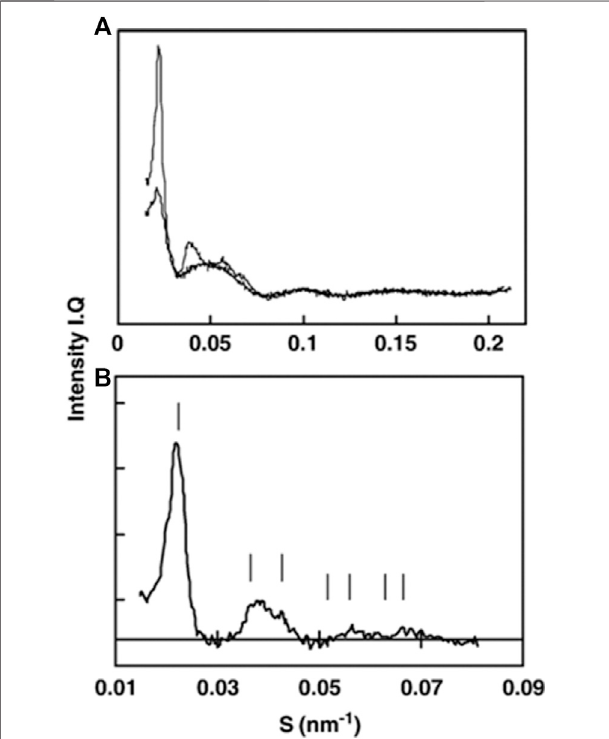
FIGURE 7 | SAXS pattern changes after single freeze – thaw cycle of prolamellarbodies. (A) Priortofreezing(thinline)andimmediatelyaftermelting (thick line). (B) Difference between curves from (A) indexed to a F d 3 m lattice [ fi gure from Selstam et al. (2007)].